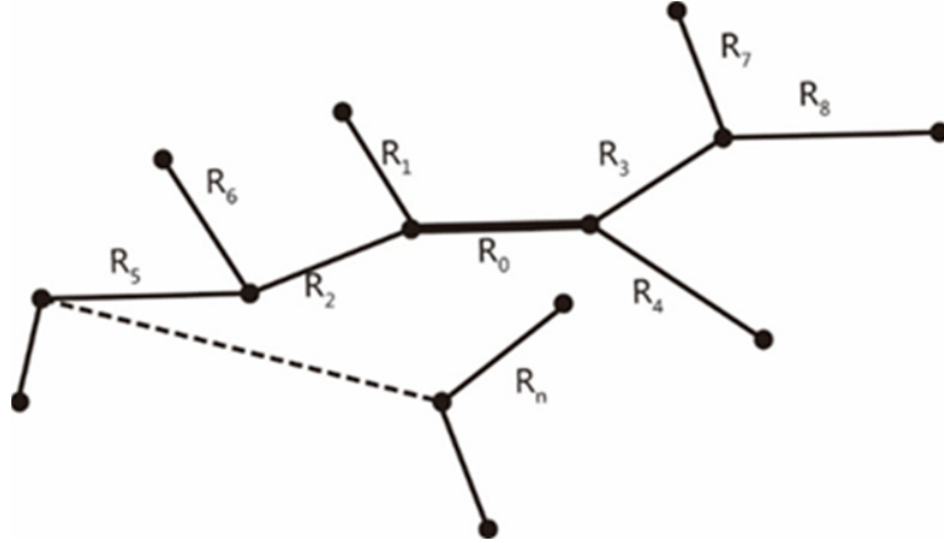
Figure 2. K -order neighborhood road segments.